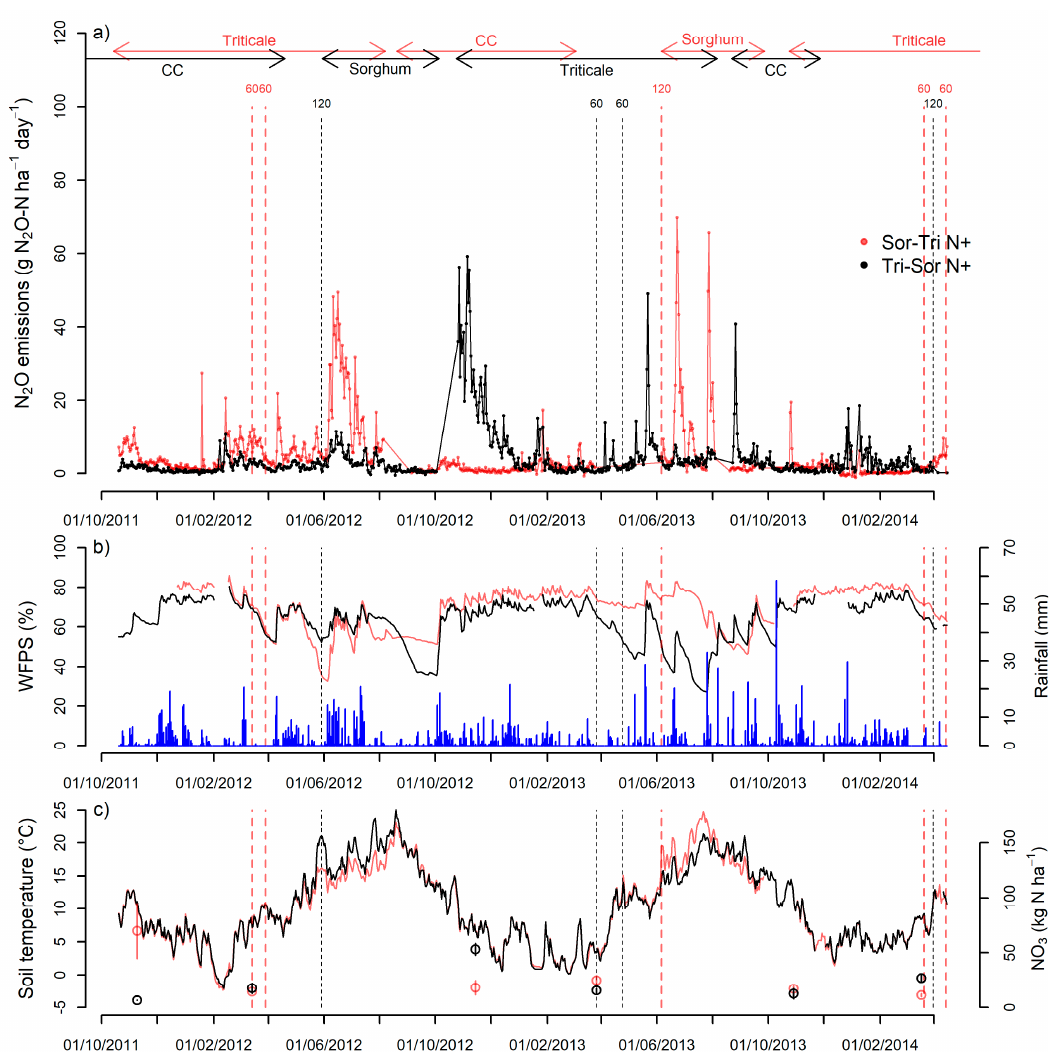
Figure 5. Daily N 2 O emissions ( a ); daily rainfall and WFPS (0–30 cm) ( b ); and daily soil temperature (15 cm) and soil nitrate content (0–30 cm) ( c ) under annual crops: Sor-Tri N + (green) and Tri-Sor N + (red). Each point in ( a ) represents a measured value (daily average for the treatment). Vertical dotted lines represent fertilization events with the N rate in kg N ha − 1 . Horizontal arrows in ( a ) indicate the crop duration (between sowing and harvest or destruction). CC, catch crop. Vertical lines in ( c ) represent the standard deviations for soil nitrate content. See Table 1 for treatment abbreviations.